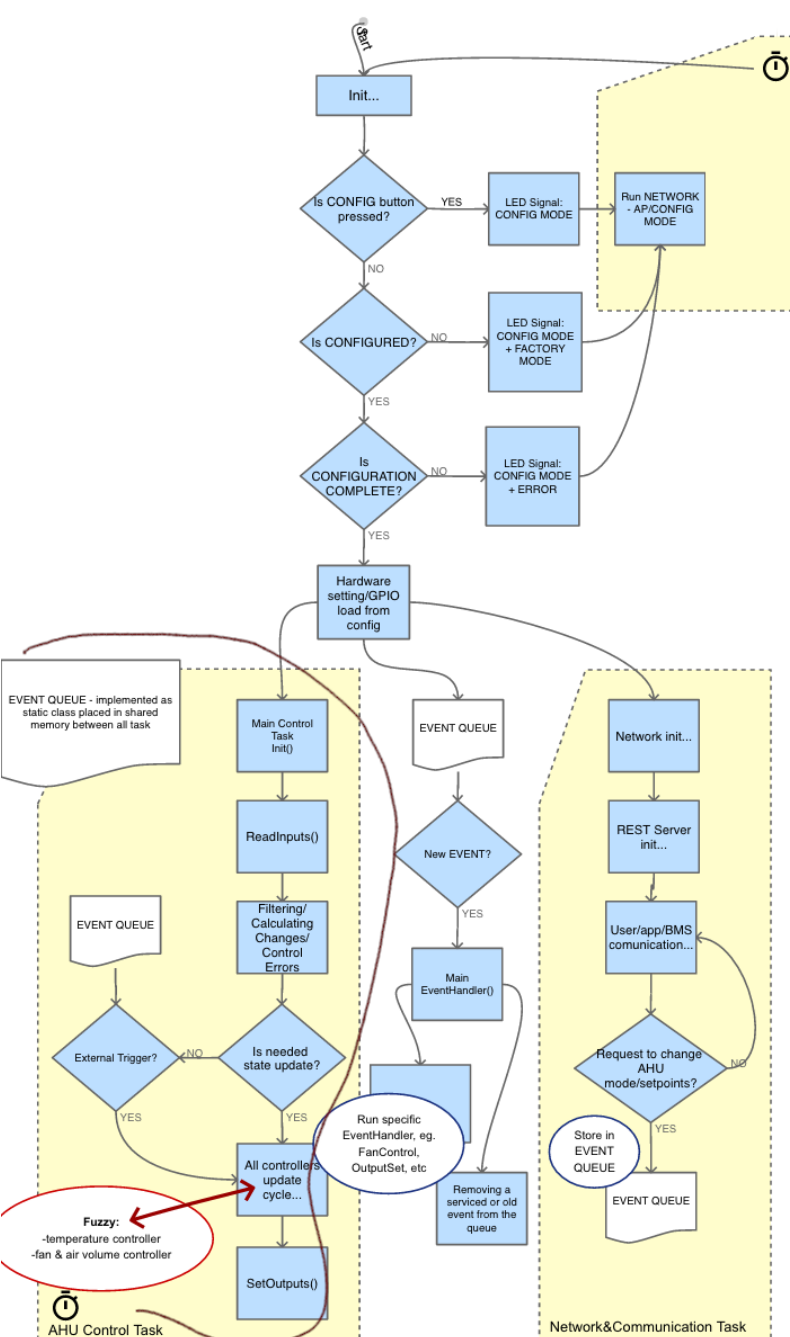
Figure 8. A general guideline for the controller firmware architecture. The task on the left is responsible for executing the controller